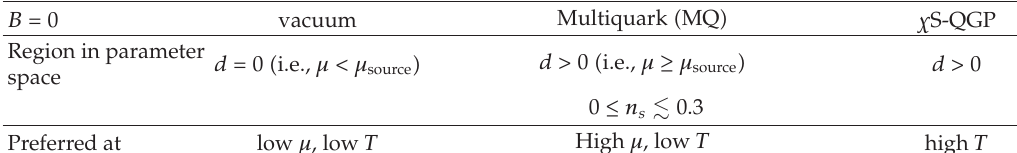
Table 1: Summary table of the phases in the deconfined Sakai-Sugimoto model, B represents the external magnetic